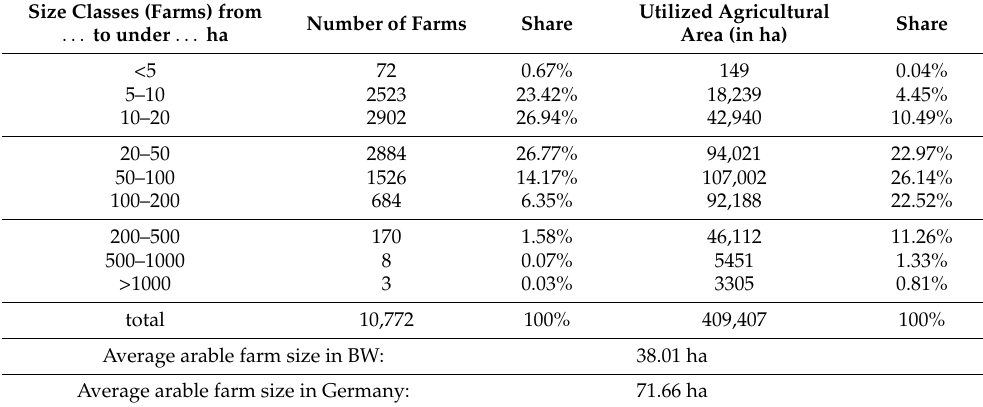
arable farm in the state. Farms in the agricultural statistics over 200 ha were combined to Farm 3 and represent only 3% of the arable farms in BW. However, with 13% of the arable land cultivated by arable farms, the three upper size classes together cultivate a similar Table A2. Supplementary dataset of agricultural statistics for the formation of the farm models used [36,70,71]. Size Classes (Farms) from . . . to under . . . ha